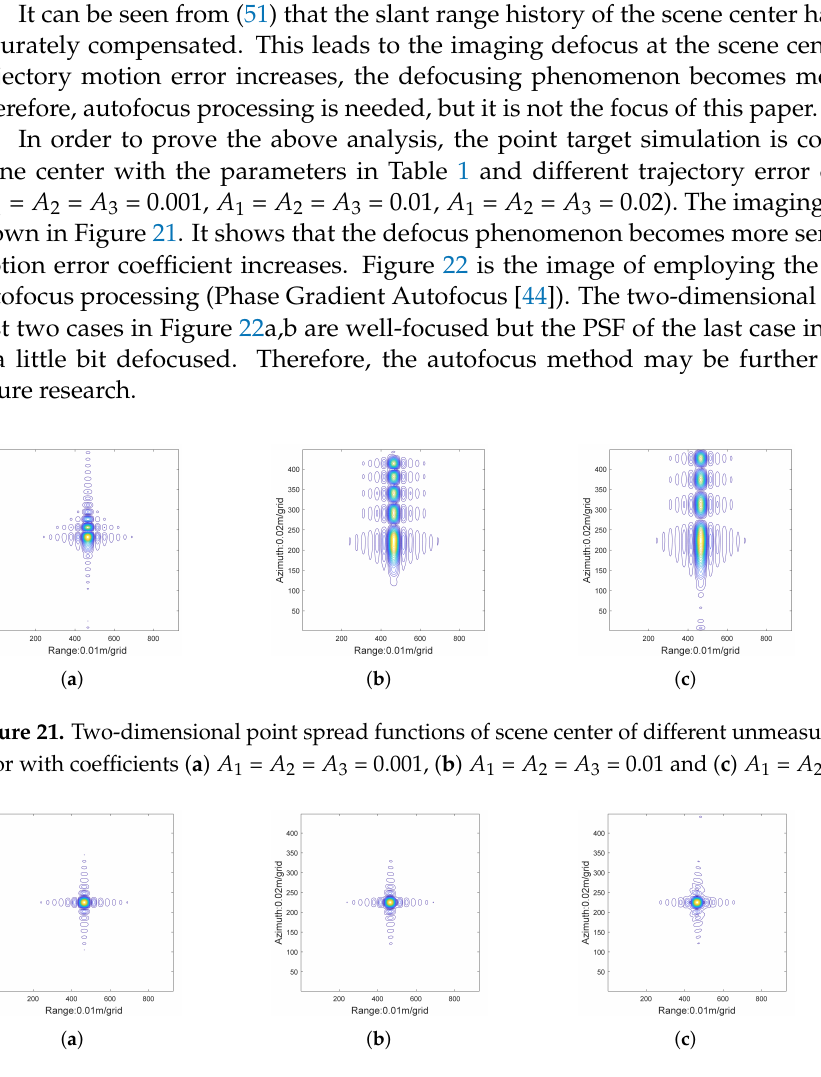
Figure 22. Autofocus imaging results of scene center of different unmeasurable motion error with coefficients ( a ) A 1 = A 2 = A 3 = 0.001, ( b ) A 1 = A 2 = A 3 = 0.01 and ( c ) A 1 = A 2 = A 3 =